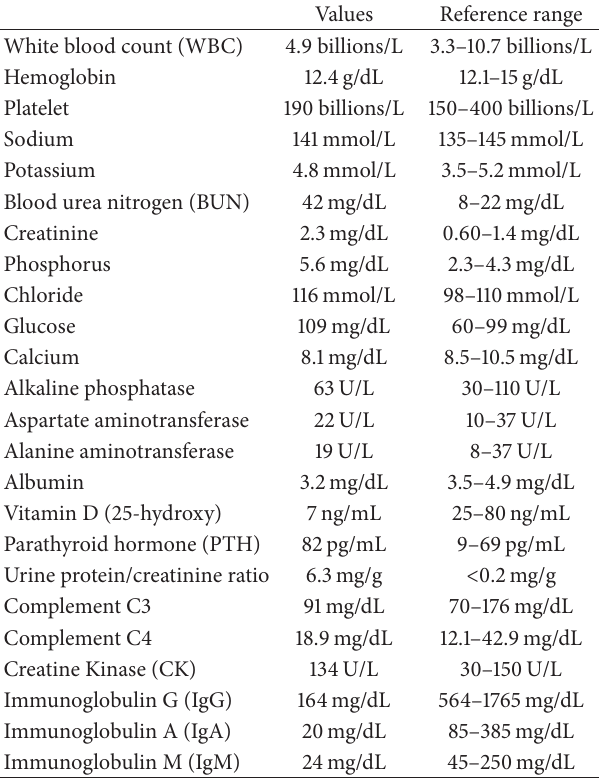
Table 1: Laboratory